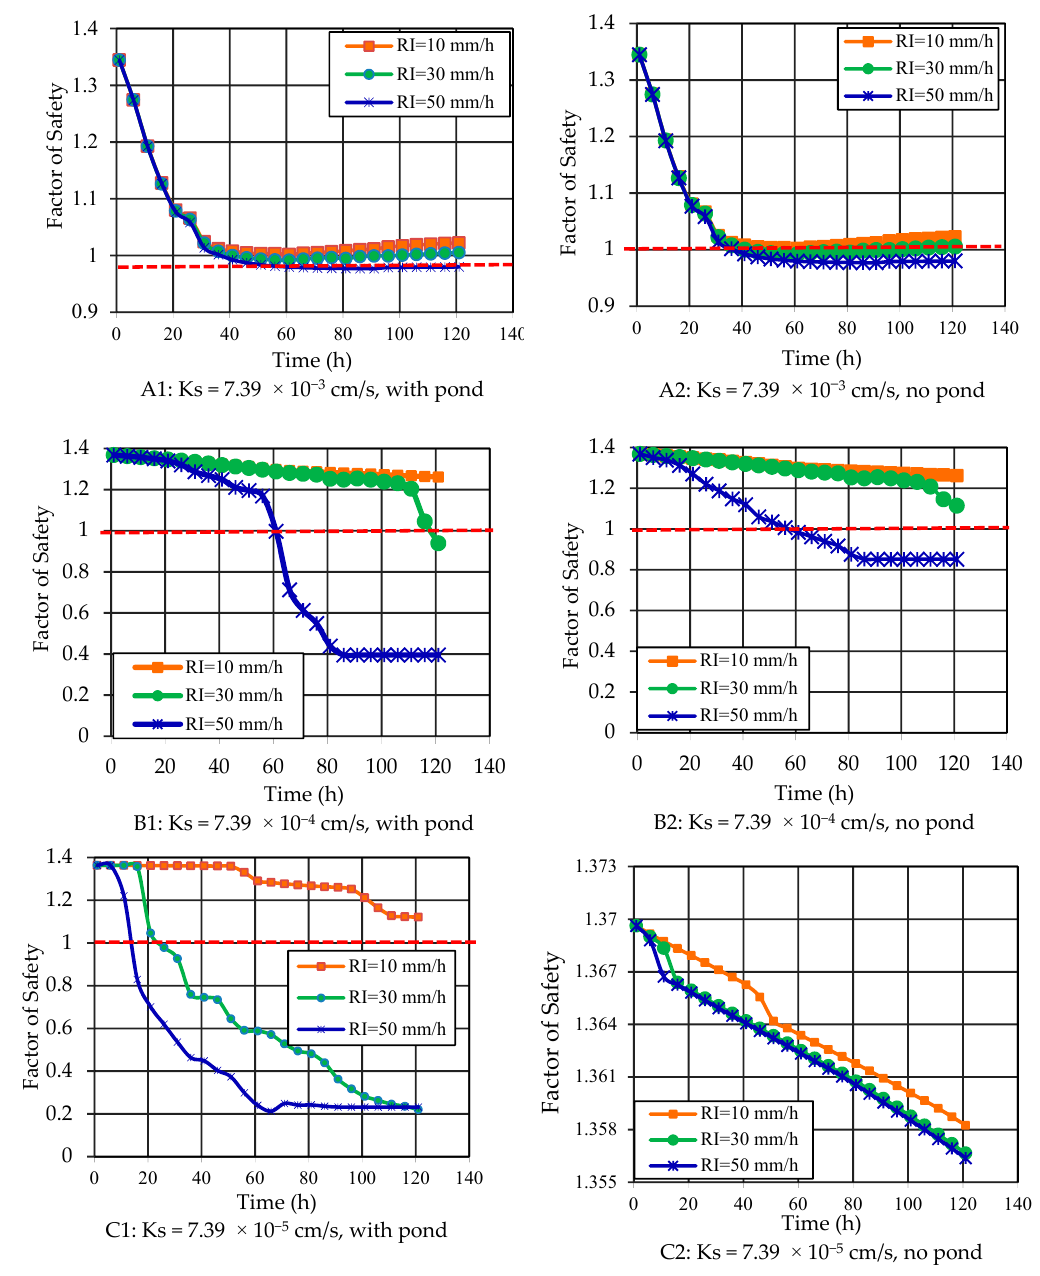
Figure 10. The change of FOS with different rainfall intensities and hydraulic conductivity with a pond and with no pond.